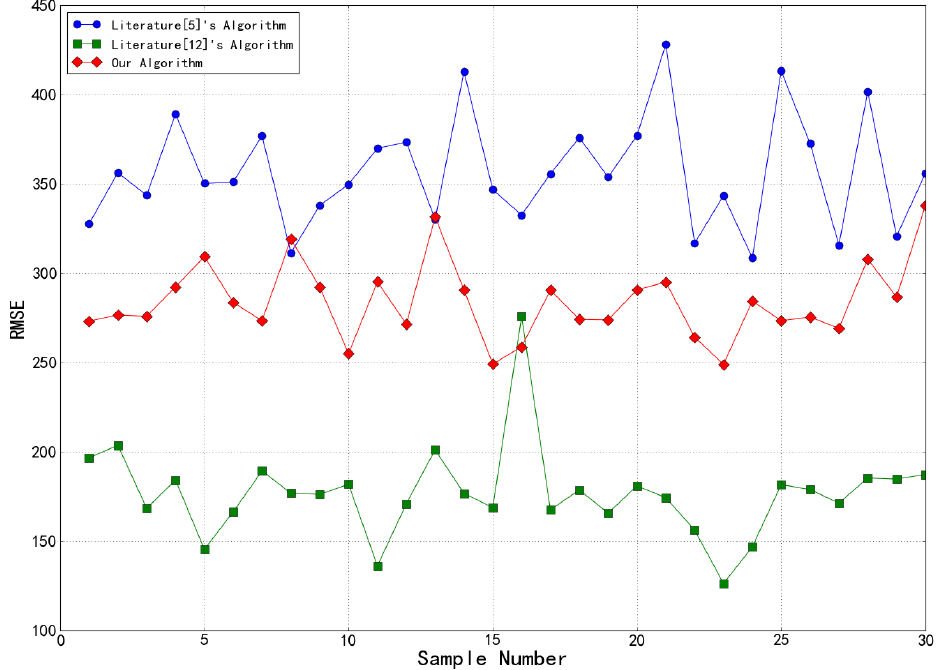
Figure 19. Algorithms accuracy comparison